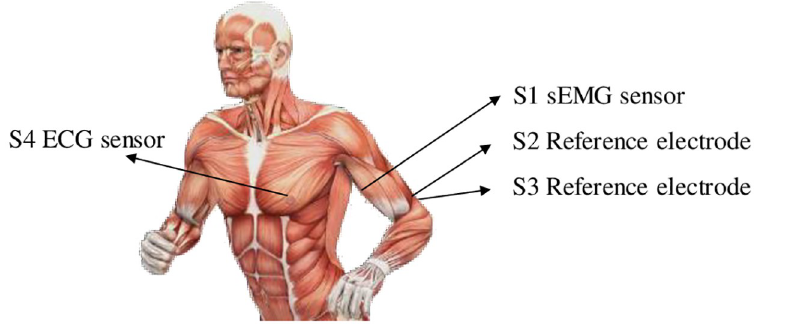
Fig 1. Upper limb test process and sensor